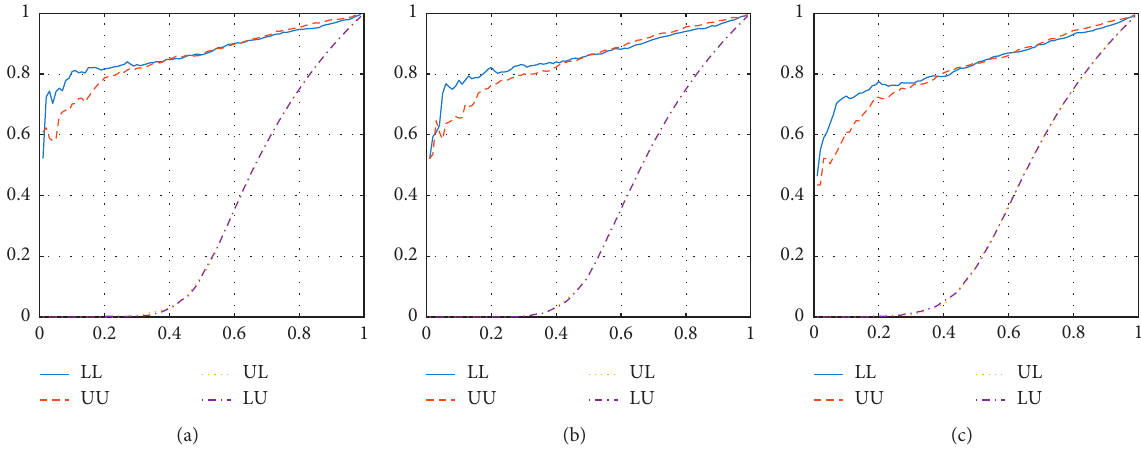
Figure 8: Sample quantile dependence curves of uniform scores. (a) HSI-CEI. (b) HSI-CCI. (c)